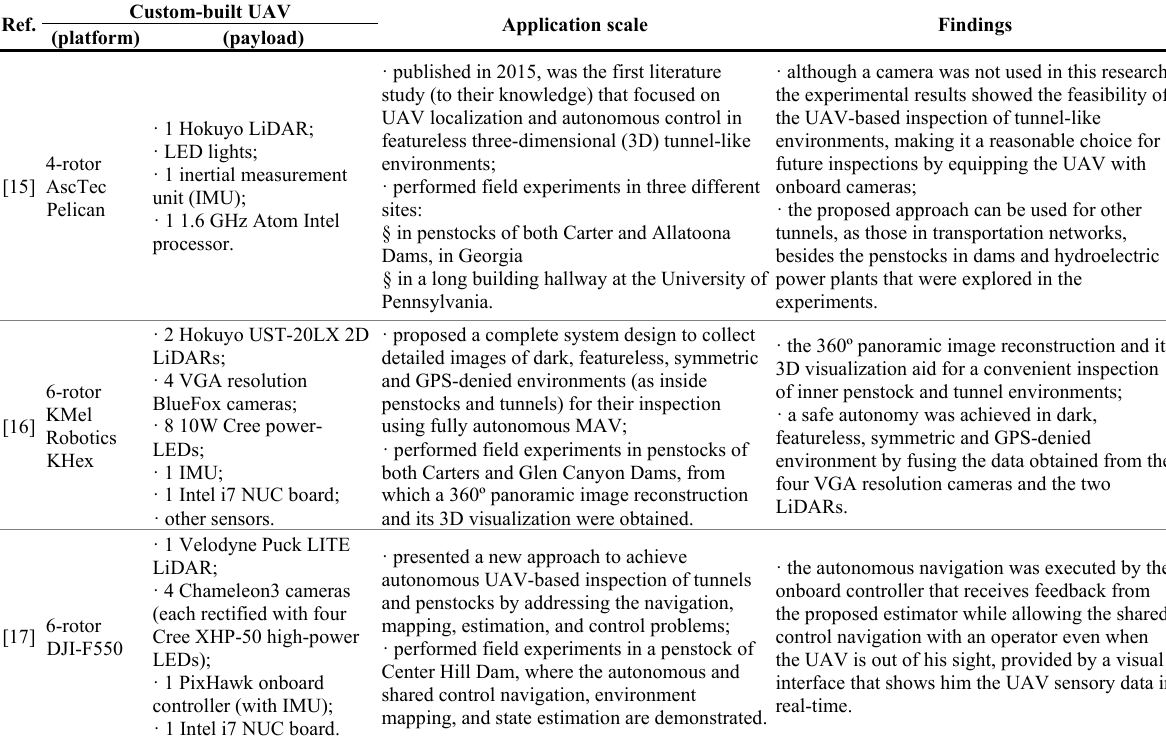
Table 1. UAV-based tunnel inspection research